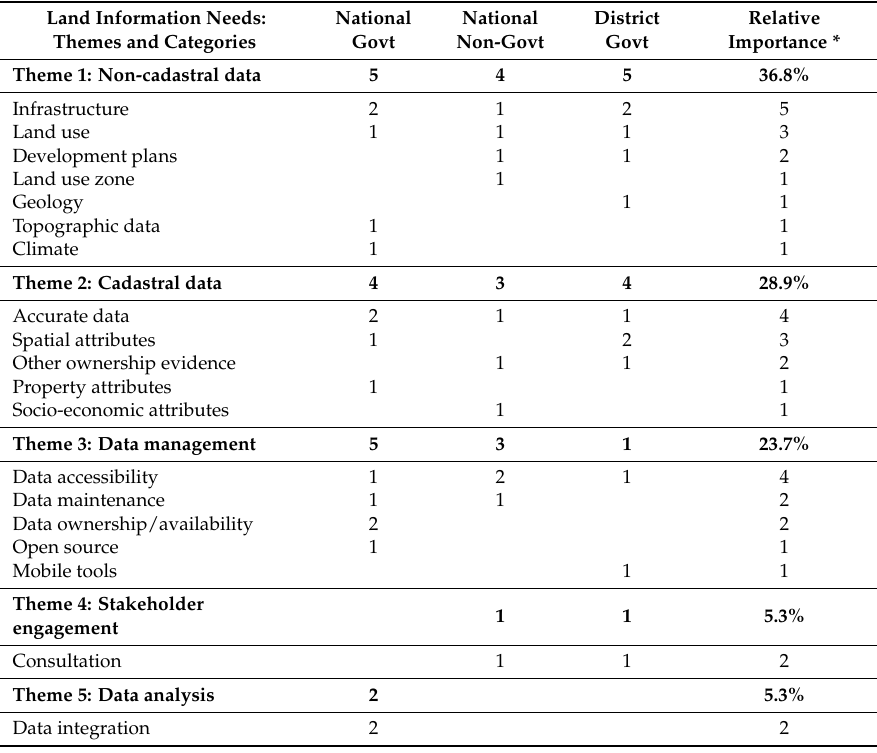
Table 5. Example of processed coded data for all workshop datasets from